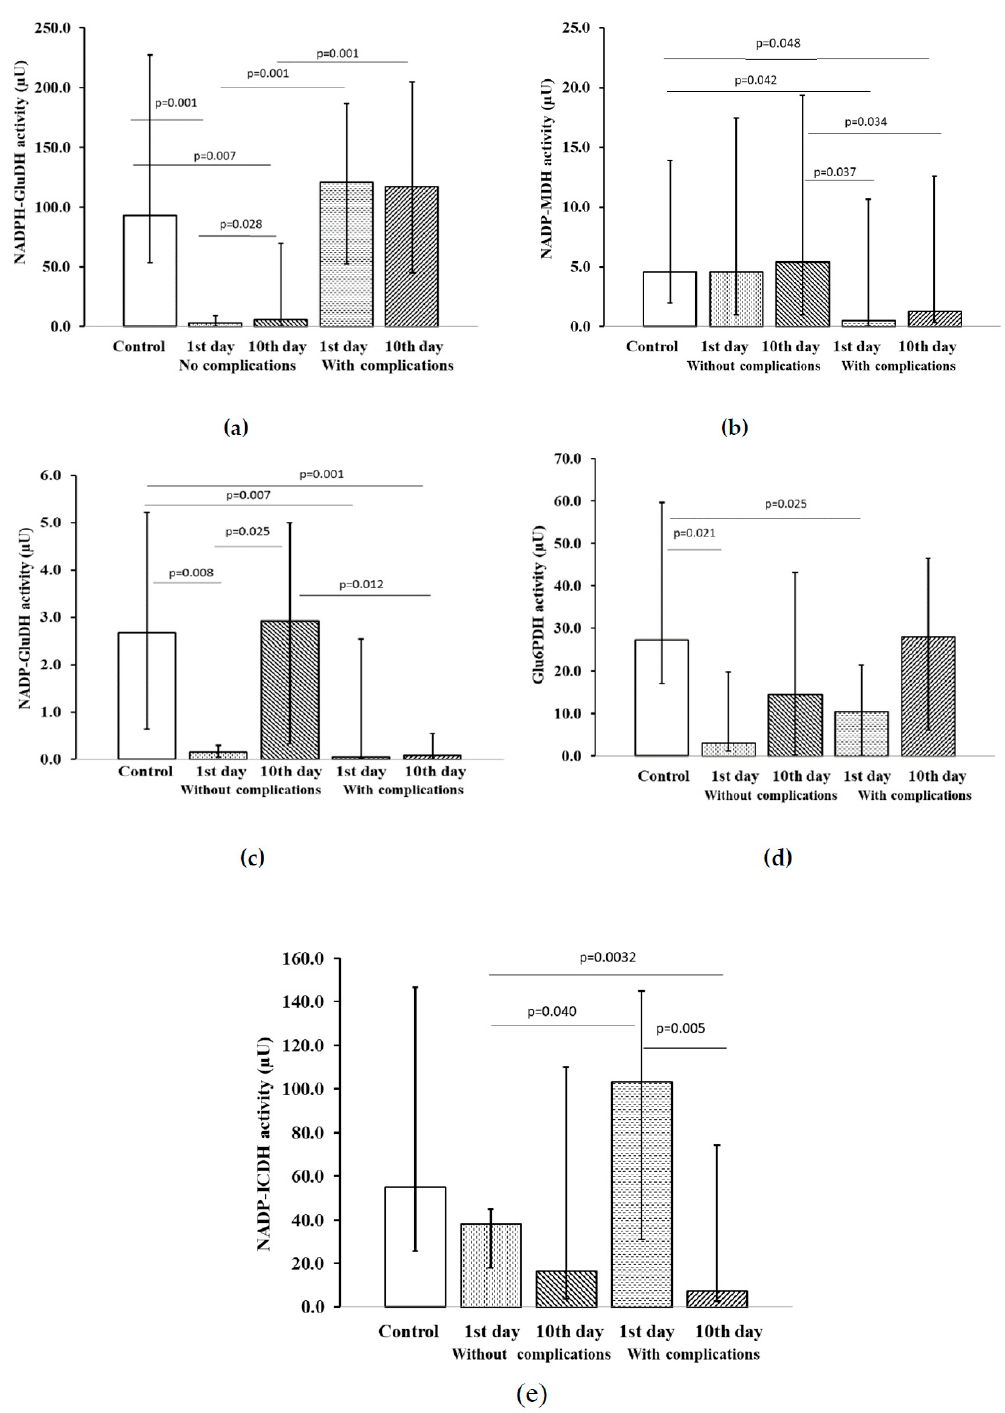
Figure 1. Activity of NADP-dependent platelet dehydrogenases in patients with acute coronary syndrome (ACS) without anxiety–depressive disorders (ADD), depending on the development of cardiovascular complications: ( a ) NADPH–GluDH activity; ( b ) NADP–MDH activity; ( c ) NADP–GluDH activity; ( d ) Glu6PDH activity; ( e ) NADP–ICDH activity. Notes: Data expressed as median and interquartile range (IQR), p < 0.05 was considered statistically significant. Wilcoxon matched-pairs test for patients without complications on the 1st vs. 10th day of the examination and for patients with complications on the 1st vs. 10th day of the examination. Mann–Whitney U test for patients vs. control and for patients with complications vs. patients without complications. Notes: µU—microunit.